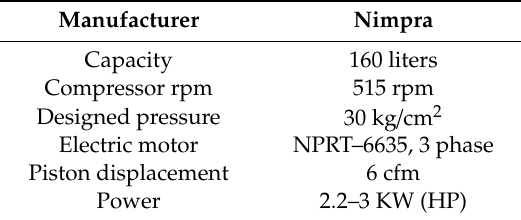
Table 2. Details of air compressor.